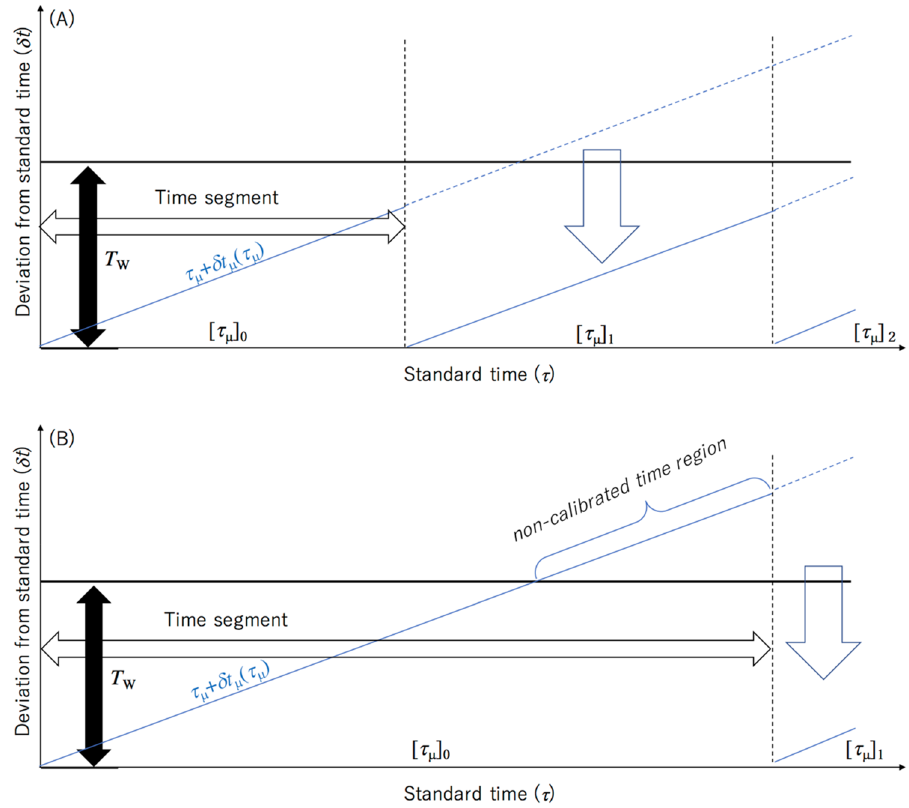
Figure 4. Principle of the resynchronization process. Blue lines indicate the local timelines of the client sensors. Solid and dashed blue lines respectively indicate the timelines before and after calibrations. Black and white box arrows respectively indicate the coincidence time window and the time segment. The notations of the symbols in this figure are described in the main text. The calibration processes are indicated by blue box arrows. If the time segment is sufficiently short, the entire local timelines can be calibrated ( A ). However, if the time segment is longer and if the local timelines exceed the coincidence time window ( T W ), part of the local timelines cannot be calibrated as indicated by "non-calibrated time region" in ( B